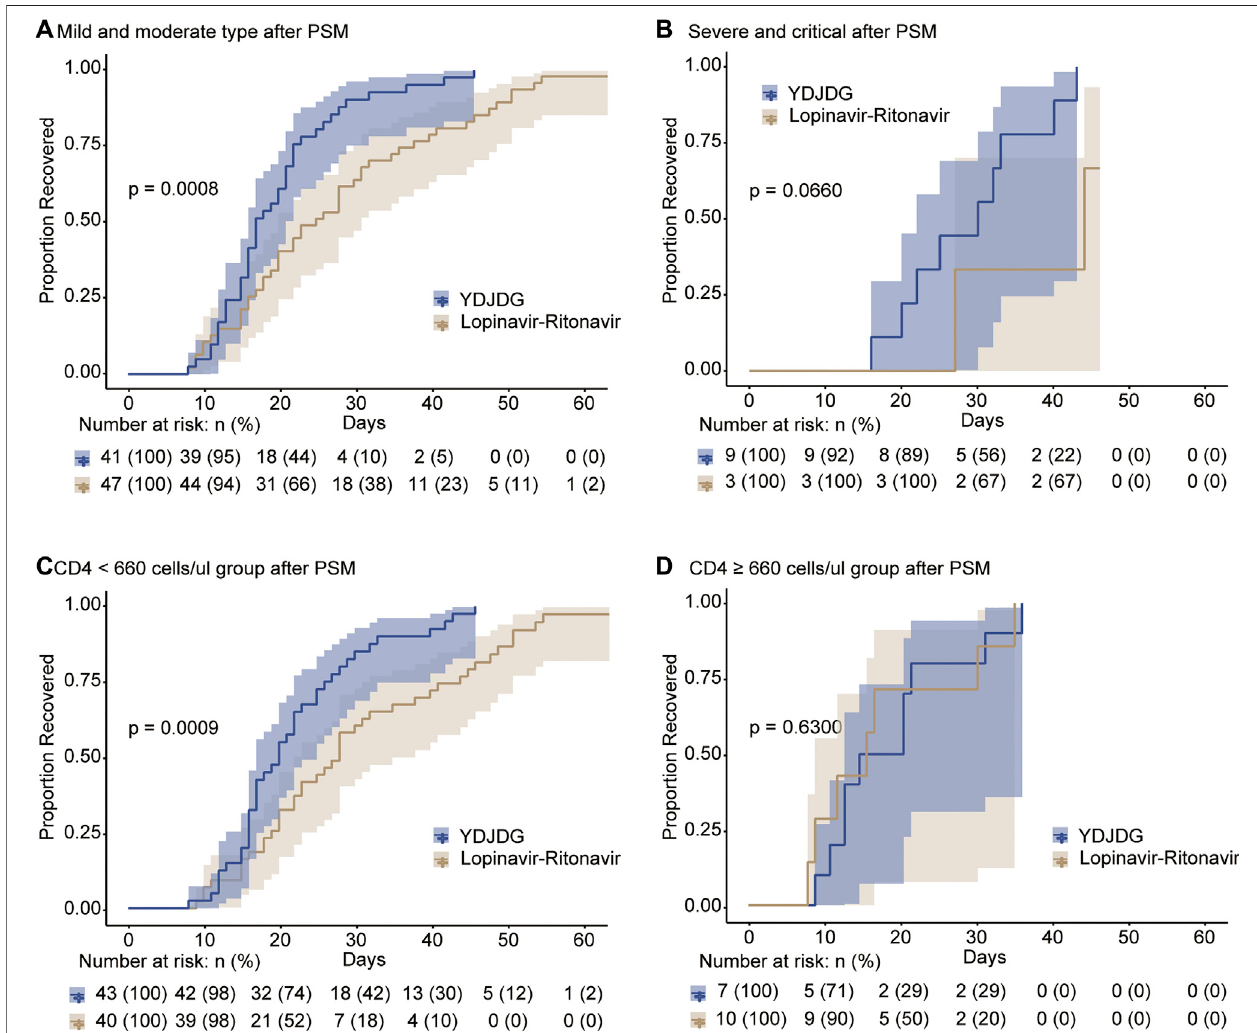
FIGURE5| Kaplan-Meier estimatesofproportion recoveryinthesubgroups.Proportionrecoveryestimatesareshown forthemild/moderatediseasetype (A) and severe/critical disease type (B) , in the CD4 < 660 cells/µL (C) and CD4 ≥ 660 cells/µL (D) subgroups.